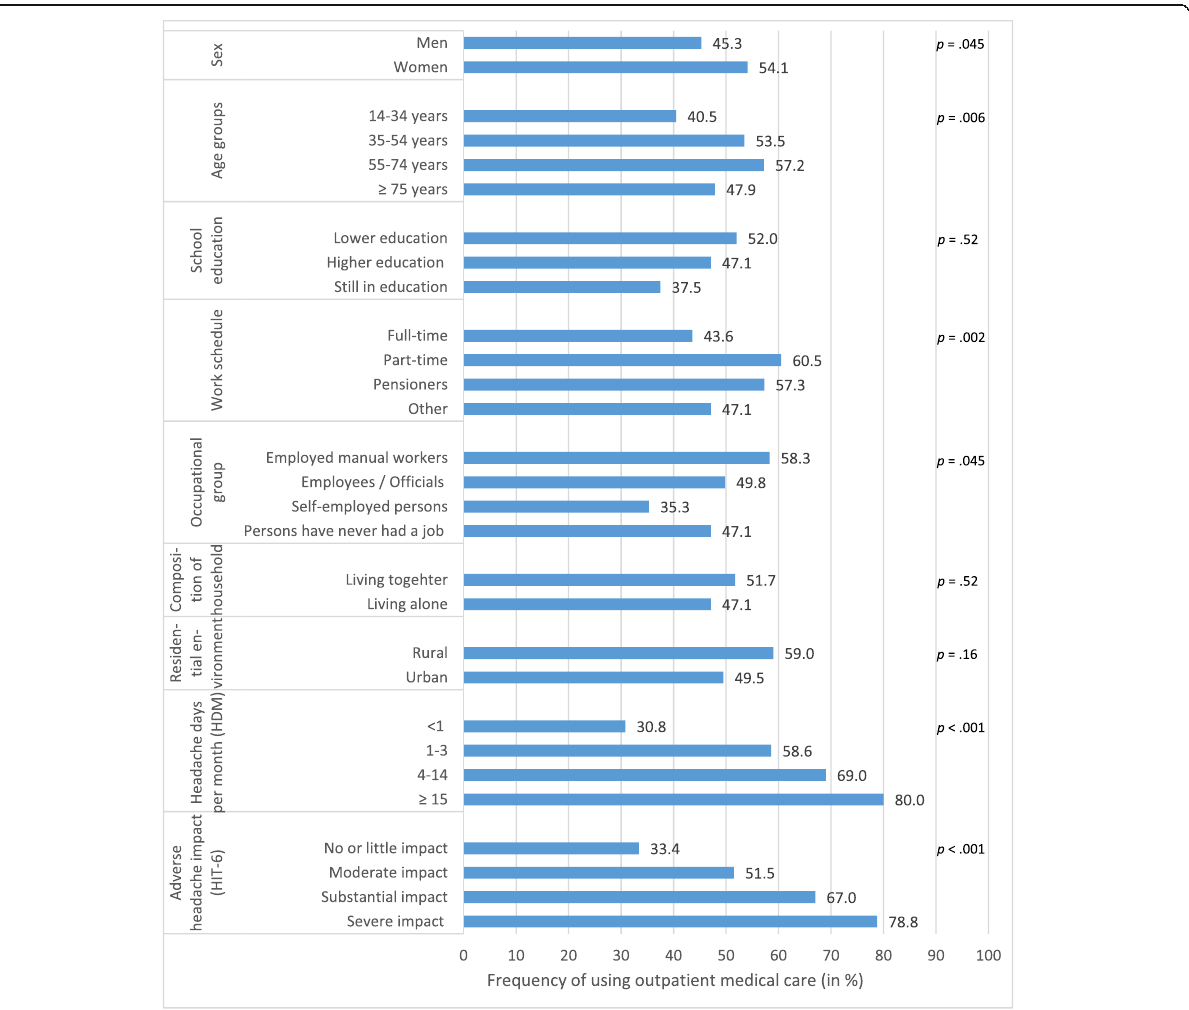
Fig. 2 Frequency (in %) of using outpatient medical care among subjects reporting headache (weighted random sample; adjusted p values based on the Holm-Bonferroni